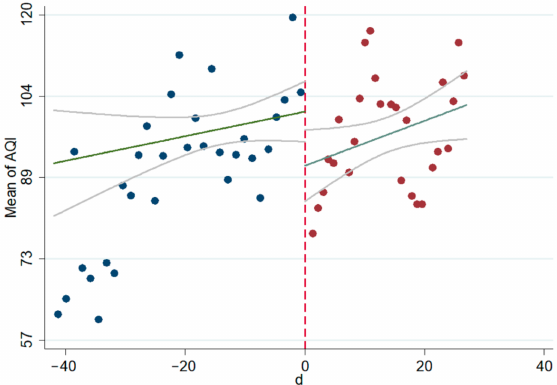
Figure 3. Scatter diagram of AQI before and after the interviews (linear).